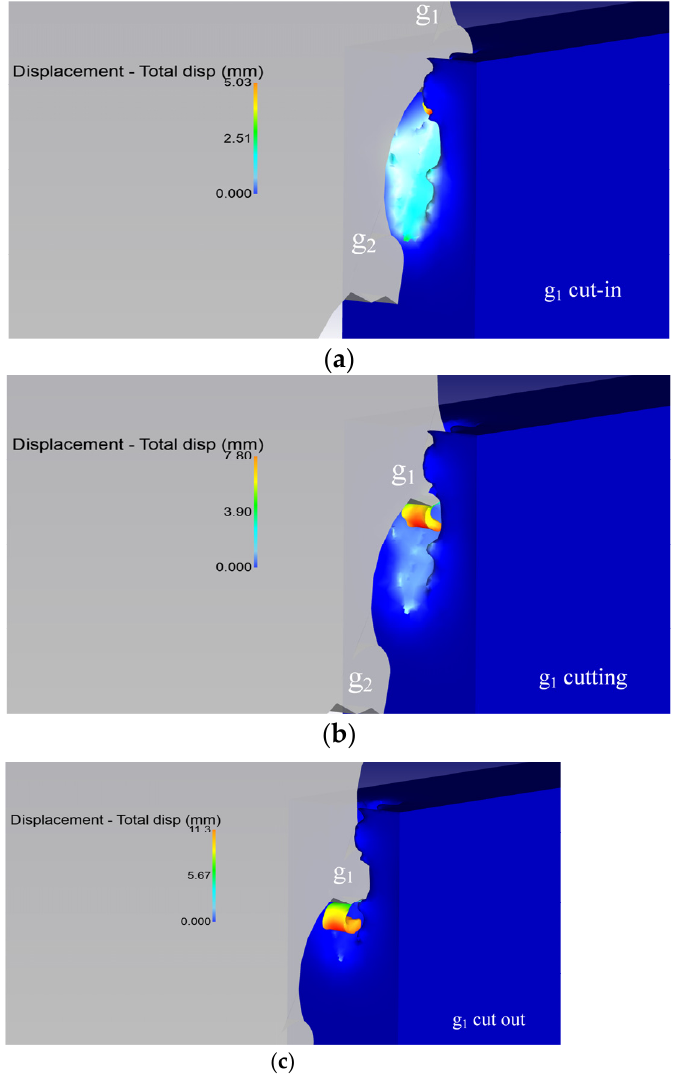
Figure 16. Saw cutting chip shape under different stages: ( a ) g 1 cut-in, ( b ) g 1 cutting, ( c ) g 1 cut out. The art of sawing a square workpiece unveils a remarkable insight into the intricate temperature field changes that occur during single sawtooth cutting, as illuminated by Figure 17. The process is characterized by the highest temperature concentrations around the tooth tip and cutting edge, which, despite being located on the rake face, remain a certain distance away from the cutting edge due to the intense tooth–chip interaction at this juncture. This interaction leads to the highest surface temperature of the workpiece being found at the bottom of the chip, where it encompasses a large area. The transient sawing temperature, which is highest along the entire root, can reach an astonishing 1300 ◦ C. The cause of this heat, arising from the large amount of plastic deformation during the sawing process, stems from the friction between the serrated edge and the chip, and its inability to be transmitted in time, resulting in heat accumulation and elevated temperatures at the chip root. A comparison between the temperature distribution of the workpiece and the sawtooth illustrates that the heat generated during sawing is primarily located on the surface of the workpiece and is carried away by the chip.